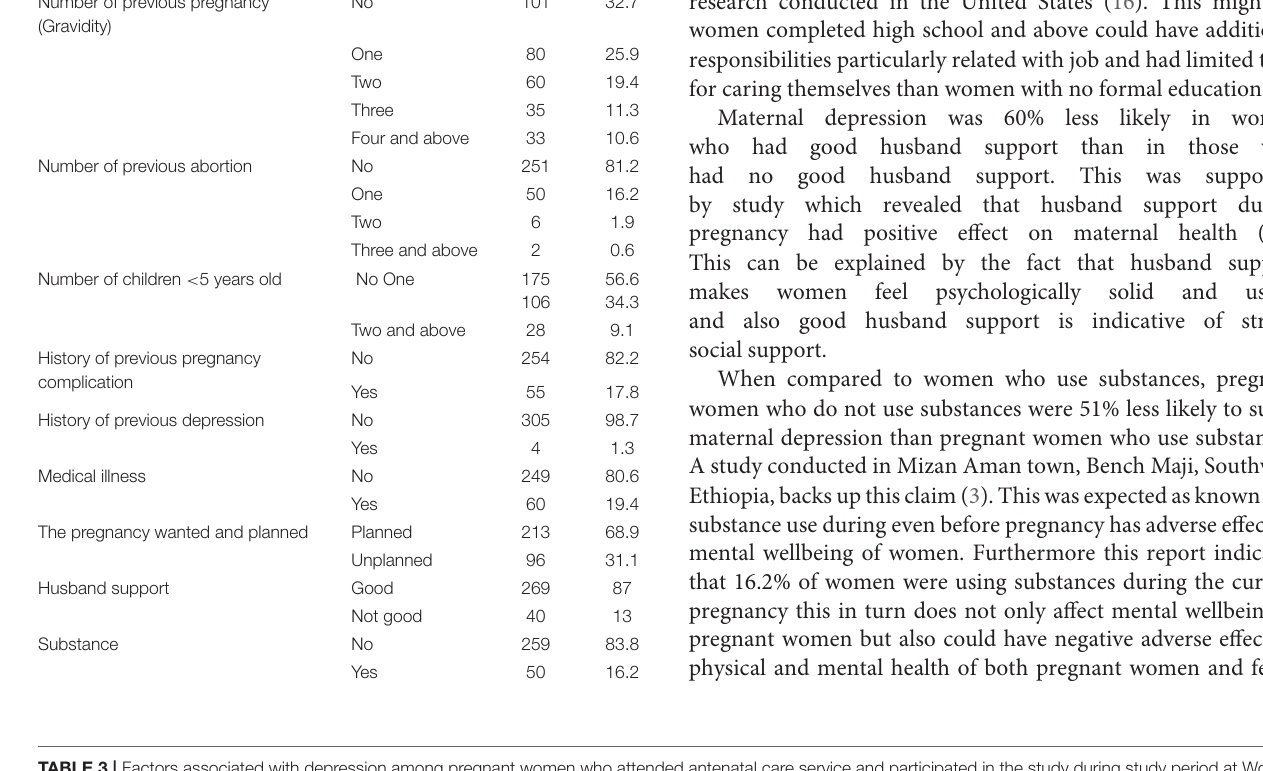
TABLE 3 | Factors associated with depression among pregnant women who attended antenatal care service and participated in the study during study period at Wolayta Sodo teaching and referral Hospital, 2018 (created by